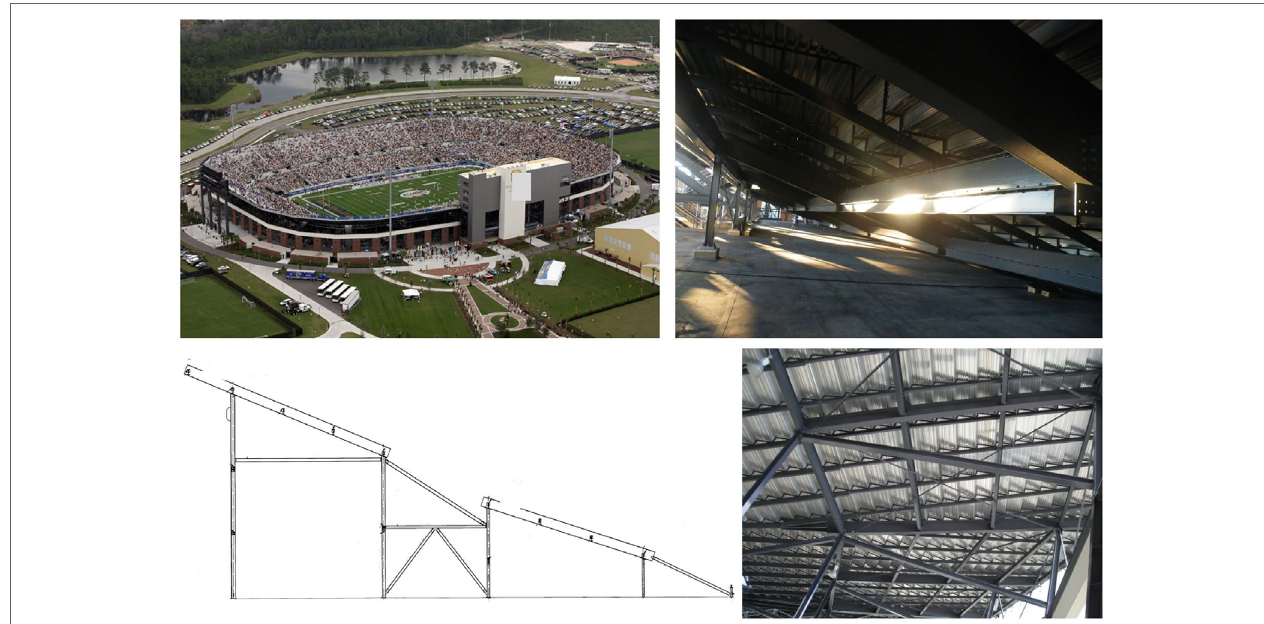
FiGURe 1 | Architectural and structural details of a